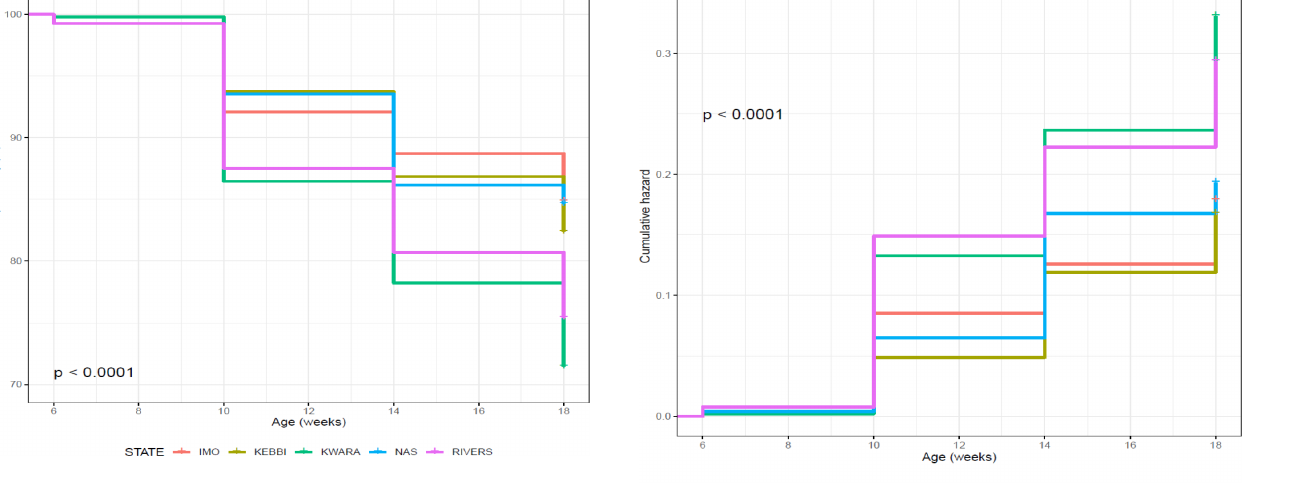
Figure 6. Effect of agroecology on overall on-farm survival perfor- mance of birds (male and female) during growing phase in ACGG Nigeria project zones (6–18 weeks) (2016–2017).